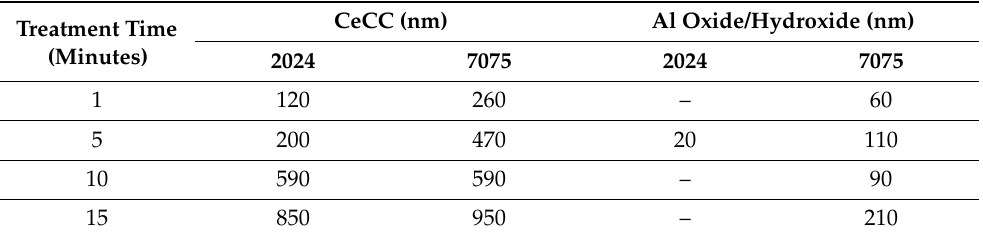
Table 4. Thickness of CeCC and alumina layer obtained from intersection of signals in GDOES depth